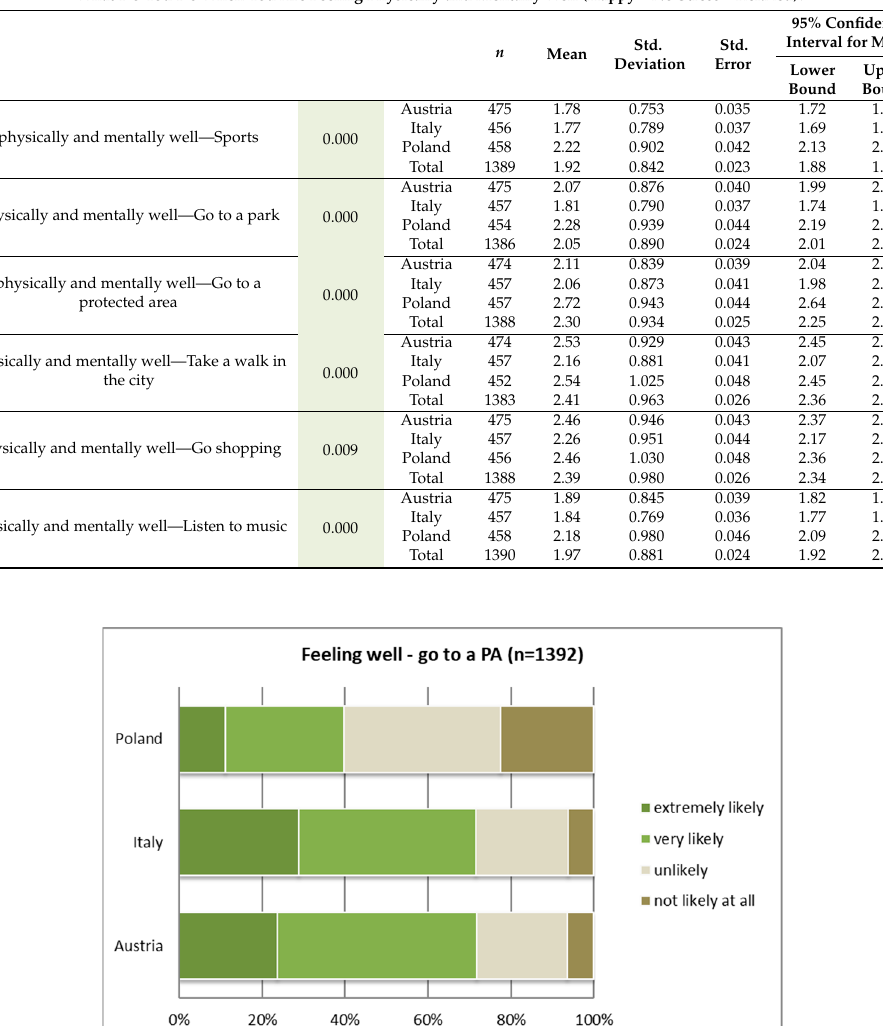
Figure 9. Symptoms improved by PA visitation—Italy ( p ≤ 0.01).